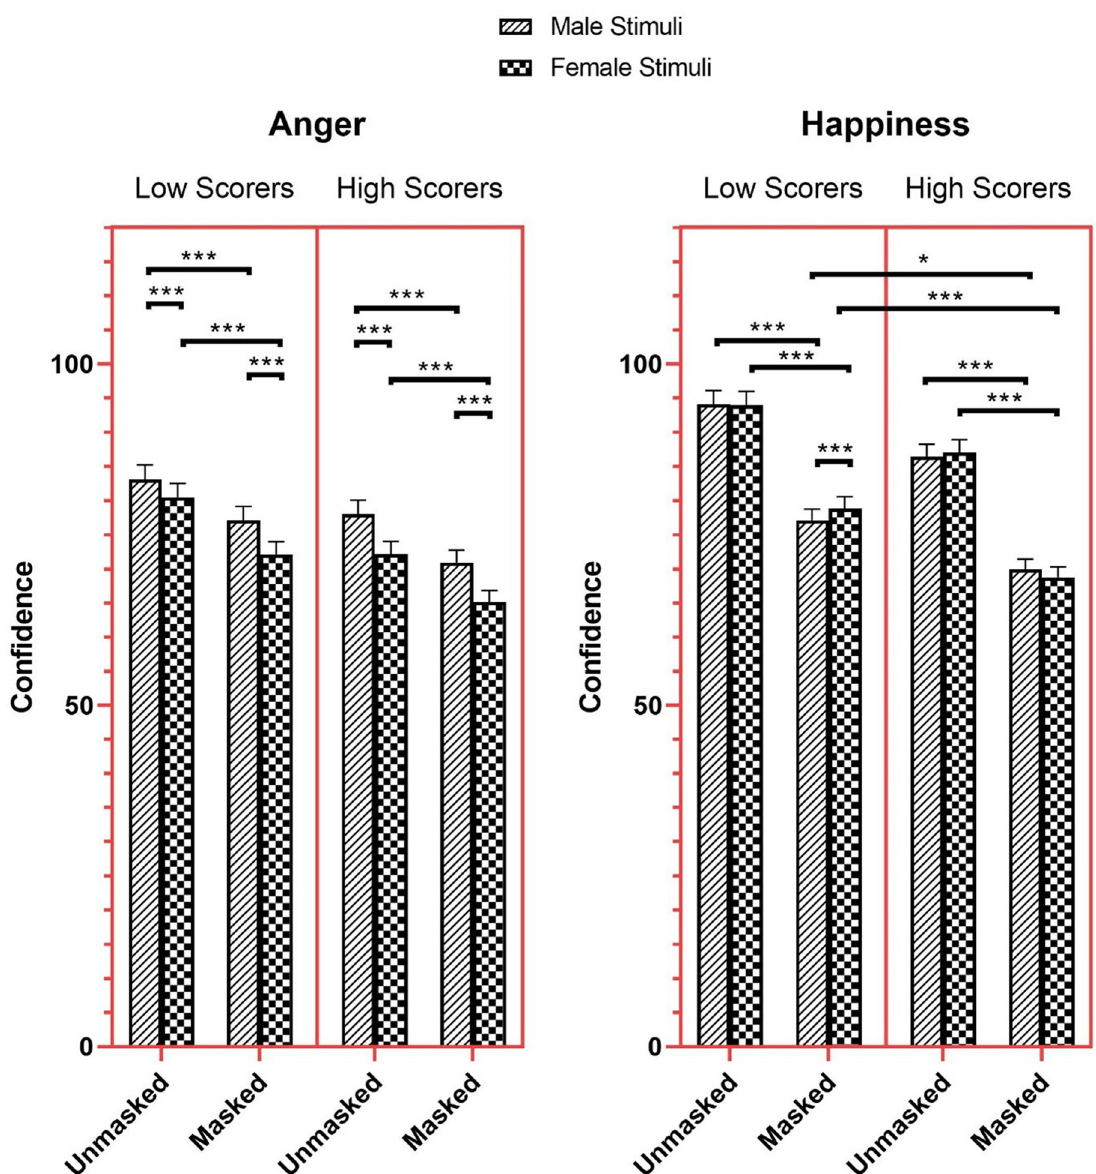
Fig 7. Confidence ratings for anger and happiness as a function of mask, AQ-10, and stimuli sex. � p < 0.05, �� p < 0.01, ��� p < 0.001.